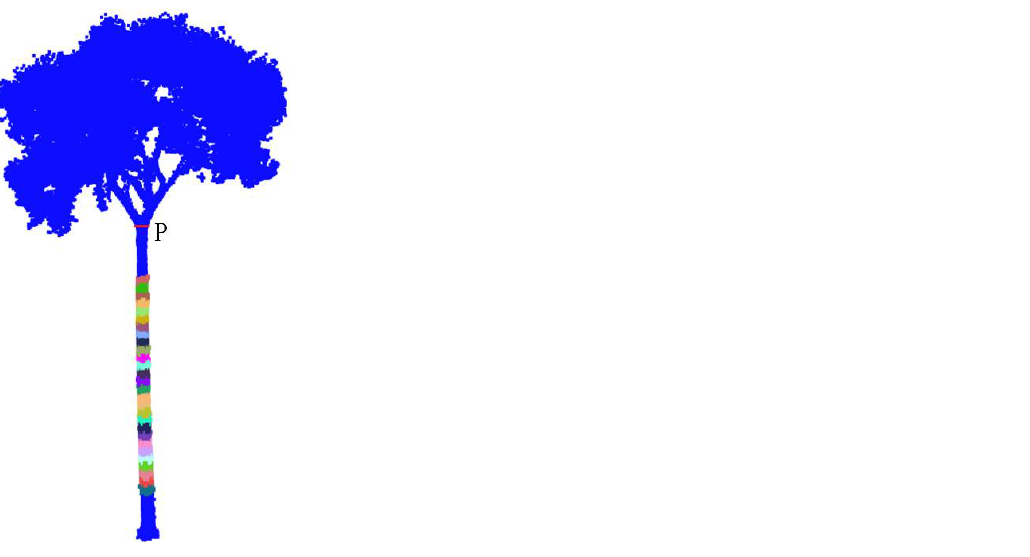
Figure 7. Automatically identify the relatively stable part of the curve of the trunk point cloud. P is the top endpoint of the trunk.